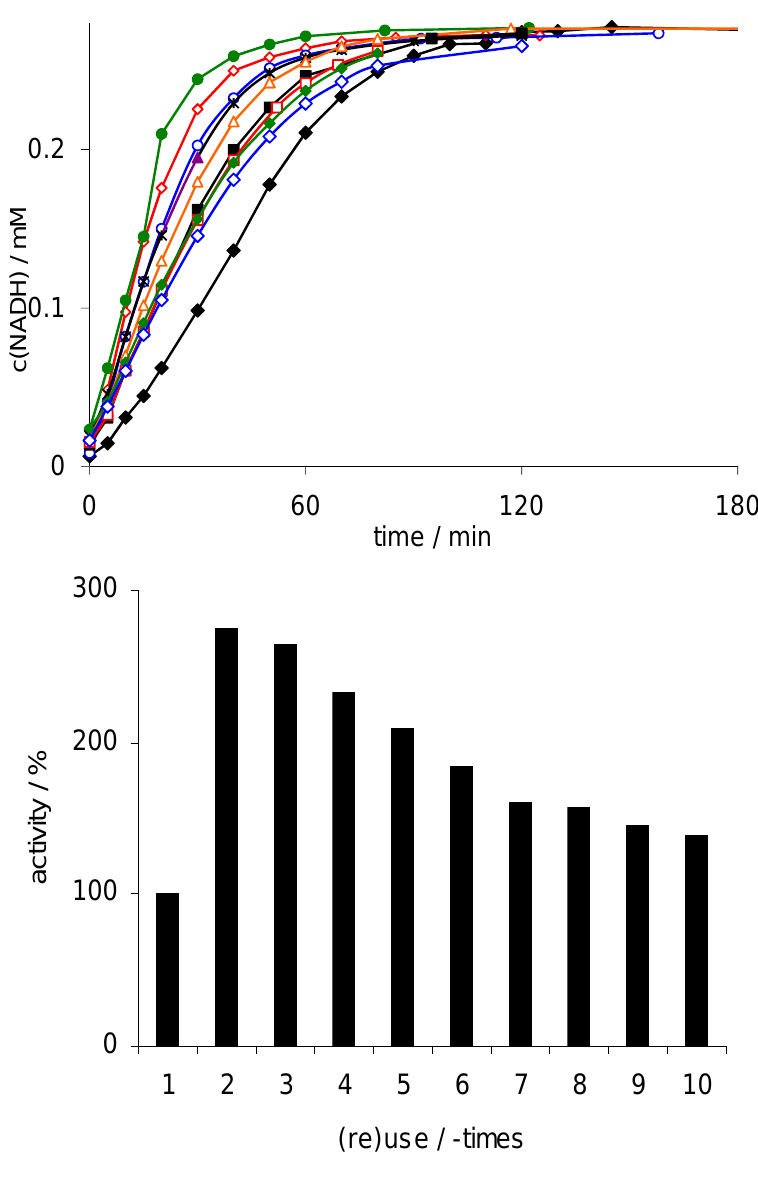
Figure 1. Recycling experiments with Rh(III)-TsDPEN. Upper: time courses of the single experiments (1: (cid:161) ; 2: (cid:145) ; 3: (cid:122) ; 4: (cid:124) ; 5: (cid:99) ; 6: (cid:85) ; 7: (cid:132) ; 8: (cid:133) ; 9: (cid:161) ; 10: (cid:145) ); lower: initial rates. Conditions: 50 mg Rh(III)-TsDPEN (0.35 μ mol), c(NAD + ) = 0.25 mM, 50 mM phosphate 0 buffer pH 7, T = 30 °C, c(NaHCO ) = 150 mM, 1,000 rpm; 100% corresponds to an 2 NADH-generation rate of 0.21 mM·h − 1